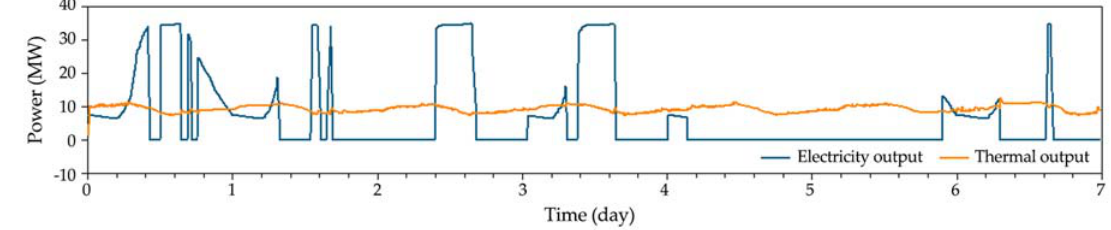
Figure 9. Simulated results of the output electricity power and thermal power.